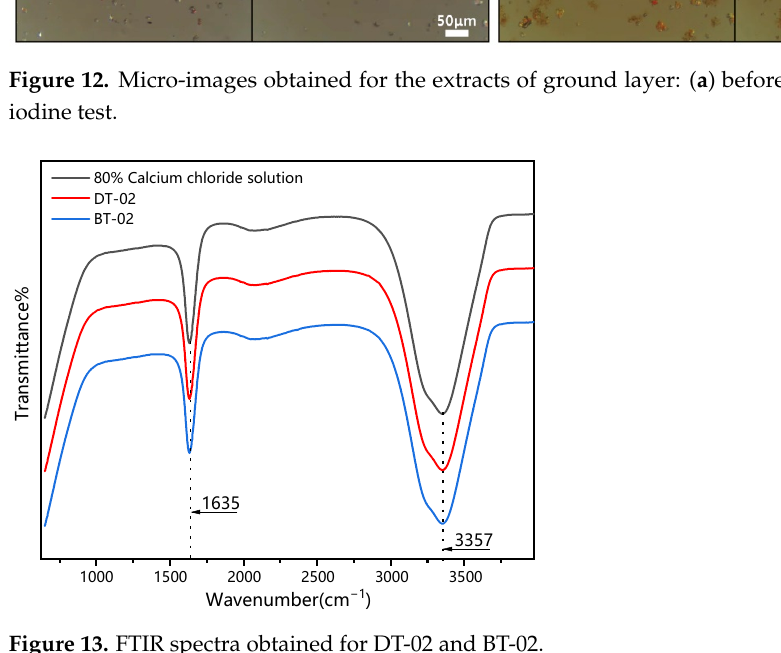
Figure 13. FTIR spectra obtained for DT-02 and BT-02.